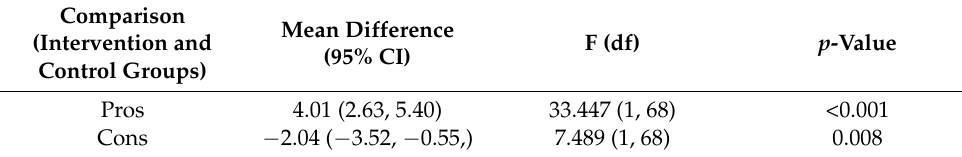
Table 3. Overall mean differences of DB-M score among two groups.